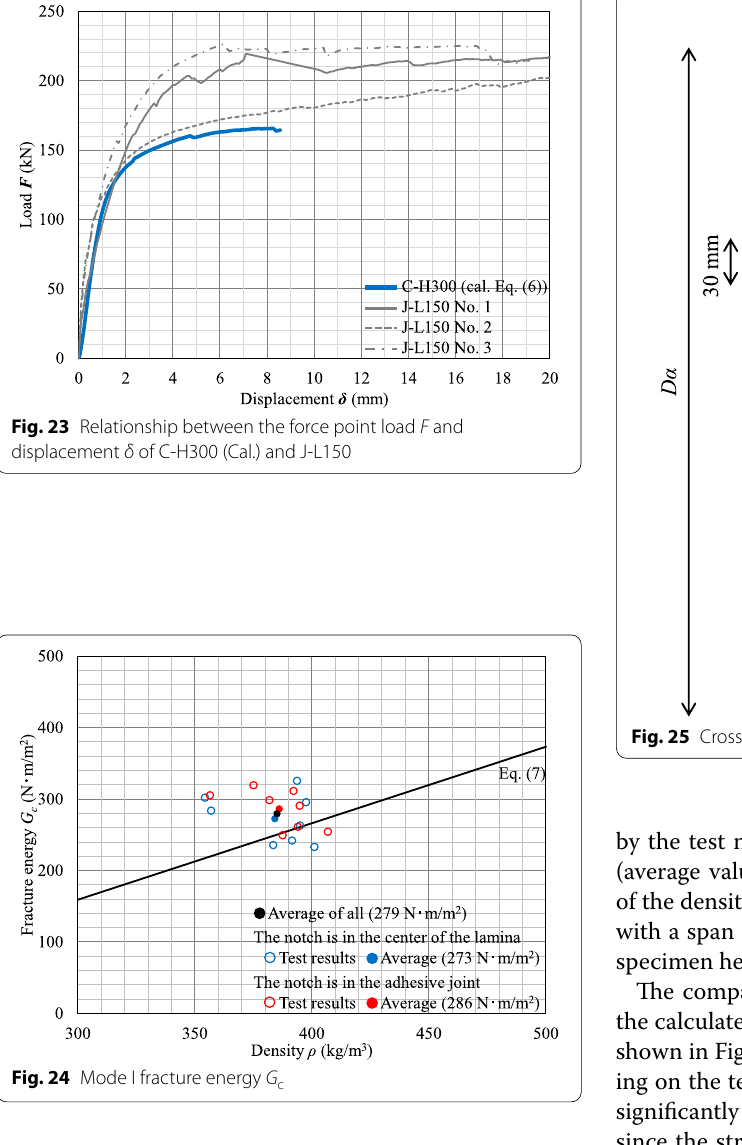
F s 9.4 N/mm 2 (average value of 30 specimens where = the average value of the density is 405 kg/m 3 ) for the test with a 25 mm 25 mm shear plane and F s × mm 2 (average value of 30 specimens where the aver-